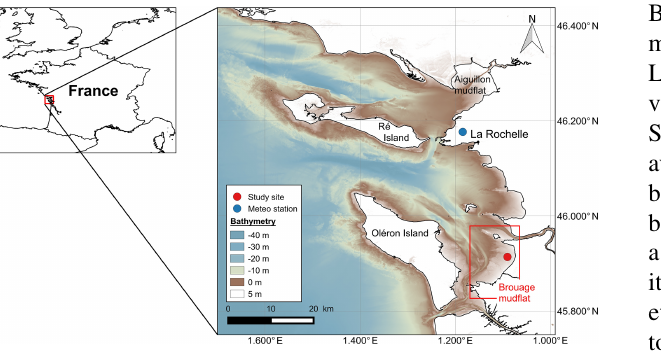
Figure 1. Bathymetric map of the Pertuis Charentais (source: French marine service for hydrography and oceanography – SHOM) and location of the main intertidal mudflats. The study site is represented by a red full point and the Meteo France weather sta- tion is represented by a blue full